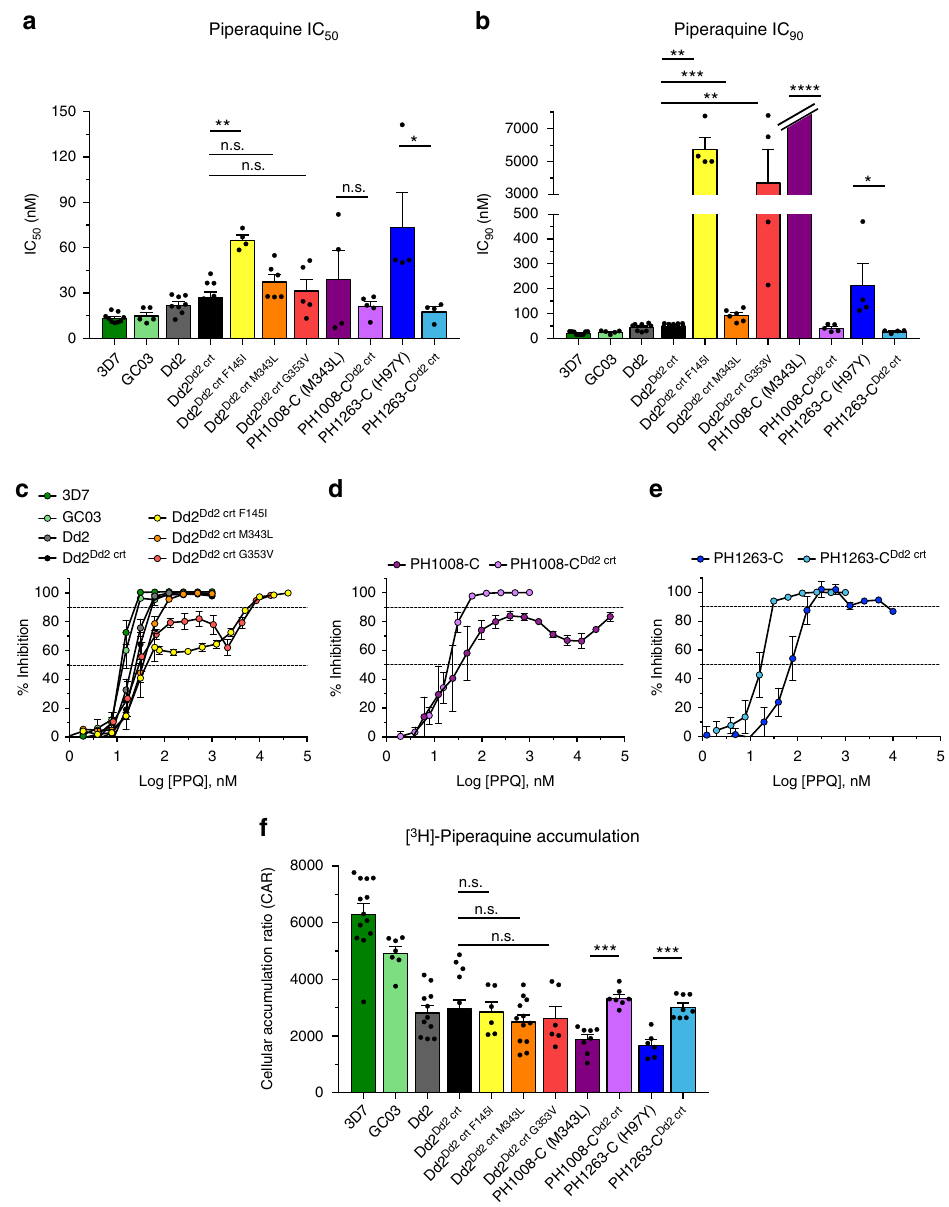
Fig. 3 PPQ dose – response and accumulation data illustrate distinct variant PfCRT-mediated PPQ resistance pro fi les. a Mean± SEM IC 50 values were determined from conventional 72-h dose – response assays performed with asynchronous parasite cultures. b Mean± SEM IC 90 data from the same assays. Note that PH1008-C never attained ≥ 90% inhibition at 50 μ M (Supplementary Table 5) and is nominally listed as 7 μ M. c – e Dose – response curves for Dd2, PH1008-C, and PH1263-C reference lines and pfcrt -edited clones. The PPQ-sensitive 3D7 and GC03 lines are shown alongside the collection of Dd2 lines as additional sensitive controls. Data show mean ± SEM percent growth inhibition as a function of [PPQ]. These results show the wide variability in dose – response pro fi les observed with the most highly resistant lines. f Cellular accumulation ratios (CAR), representing the ratio of intracellular to extracellular [ 3 H]-PPQ after 1 h incubation at 37 °C. Assays employed synchronized trophozoites, when the DV is fully formed and hemoglobin degradation is maximal. CAR results for each line are presented as means± SEMs ( N , n = 3 to 7, 2; Supplementary Table 6). a , b , f Signi fi cance was determined using Mann – Whitney U tests comparing pfcrt -edited parasites and their isogenic controls. * p < 0.05; ** p < 0.01; *** p < 0.001; **** p < 0.0001; n.s. not signi fi